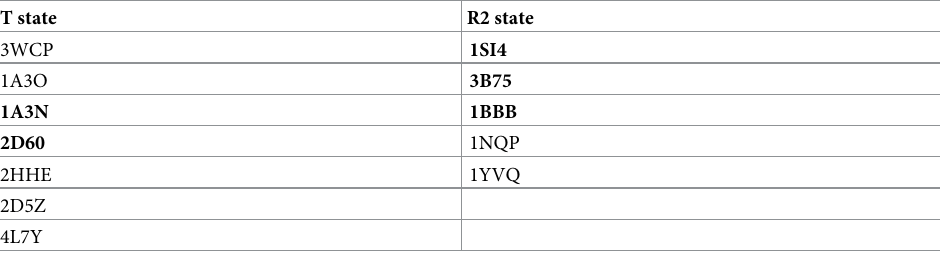
Table 2. TM-score based nearest neighbors of hemoglobin T- and R2- state structures. T state R2 state 3WCP 1SI4 1A3O 3B75 1A3N 1BBB 2D60 1NQP 2HHE 1YVQ 2D5Z 4L7Y Overlapping DSS- and TM-score nearest neighbors are marked in